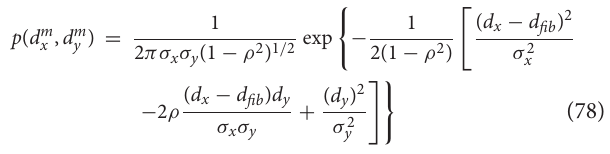
This leads to the structure shown in Figure 6A , where the paracrystalline lattice is made up of parallelograms whose edges are defined by the components of one-dimensional paracrystals. In order to create a hexagonal paracrystalline lattice, six sectors are introduced within the transverse plane, see Figure 6B , and procedure; employing different angles γ . The